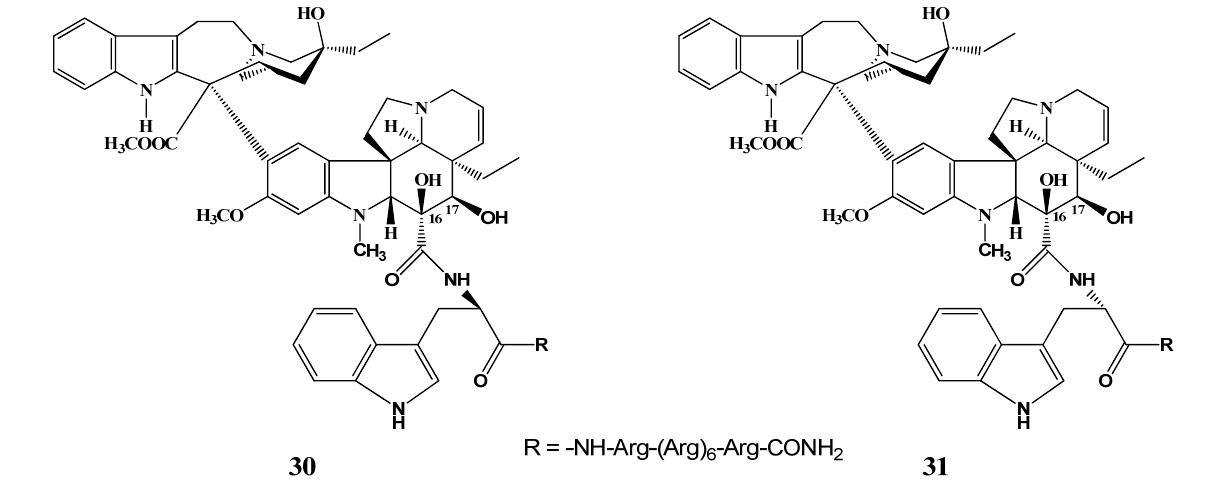
Scheme 12. Vinblastine derivatives conjugated with carrier